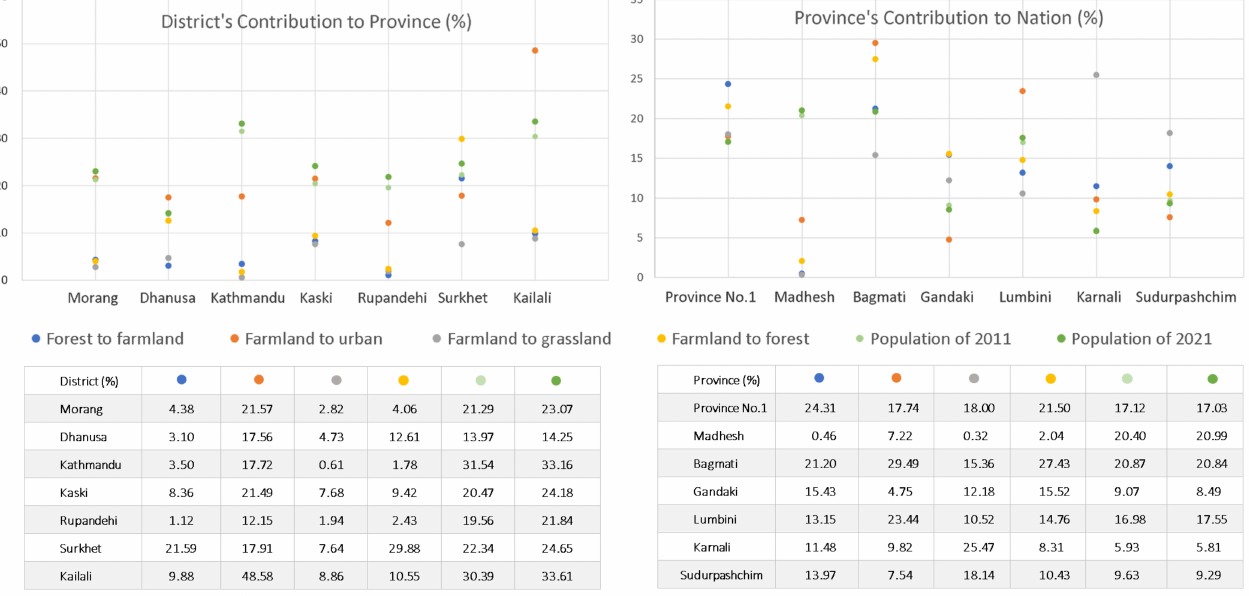
Figure 8. District’s contribution to province (DP) and province’s contribution to nation (PN) from 2016 to 2019. The contribution represents the proportion of specific land change area or population at the first, smaller scale to the one at the second, larger scale.